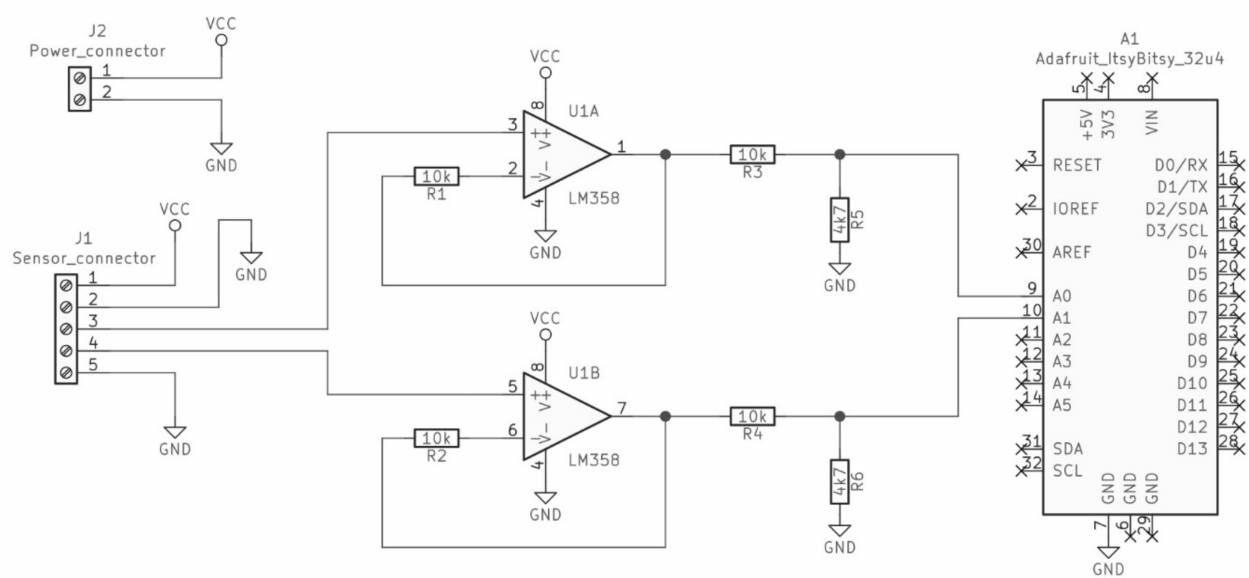
Figure 2. Diagram of ionization sensor signal processing